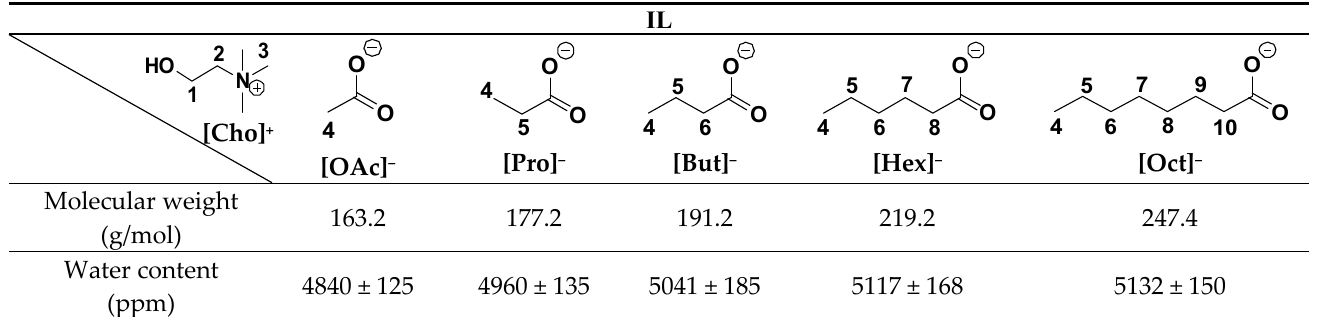
Table 3. Chemical properties of the ILs used in this work.